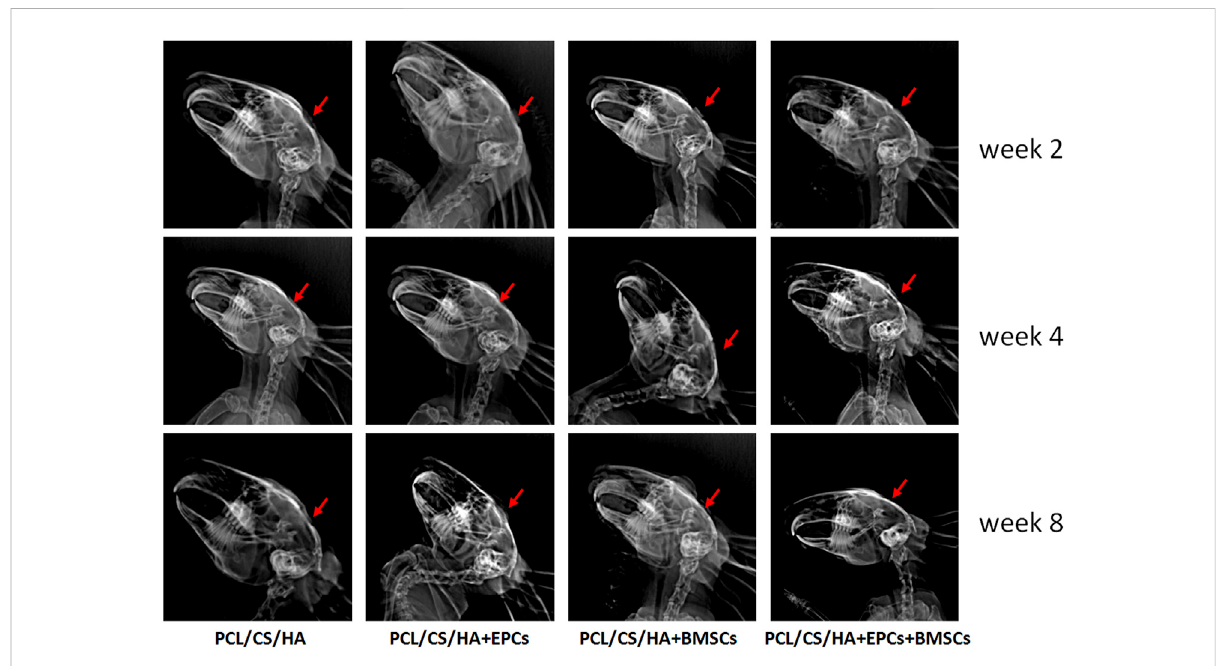
FIGURE 7 Evaluation of calvarial repair by X-ray images after 2, 4, and 8 weeks of implantation. The red arrow indicates the defect area receiving scaffold implantation.